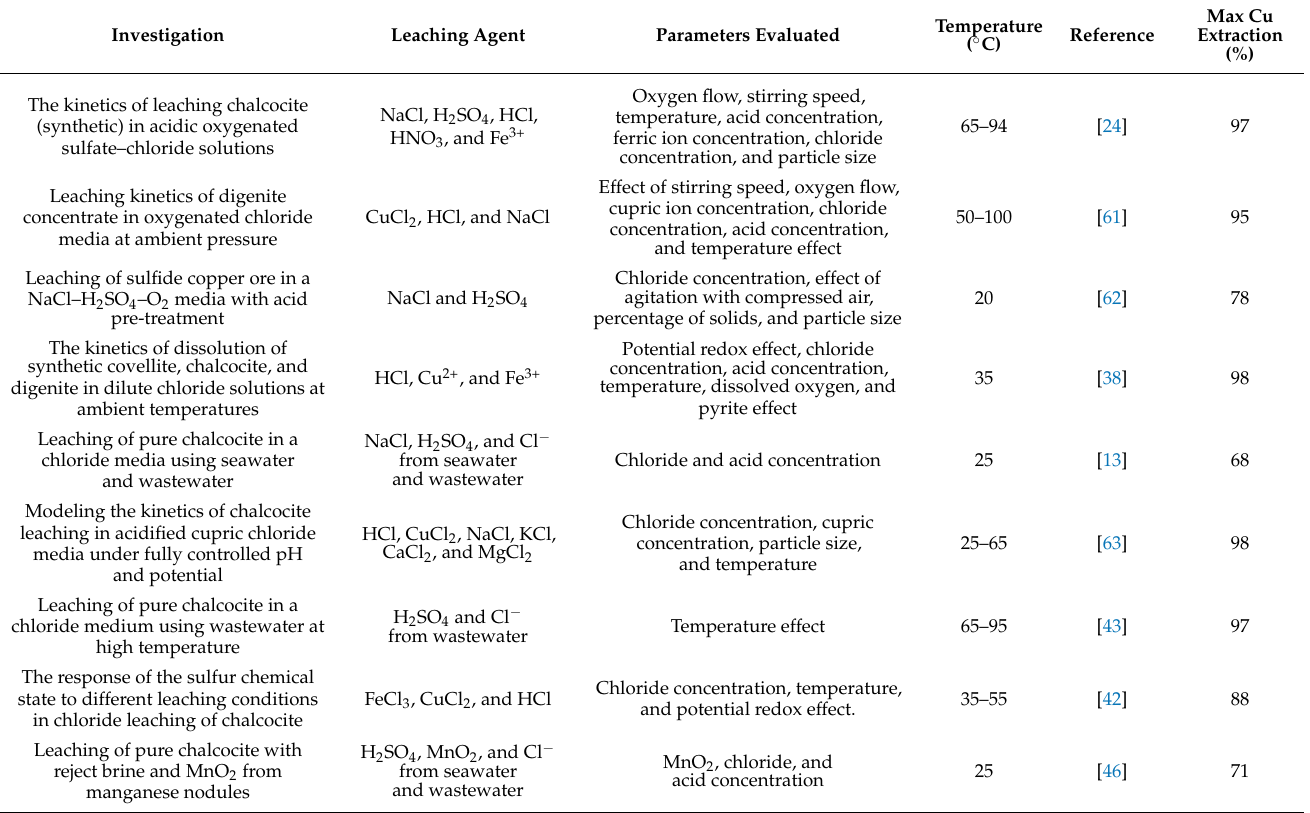
Table 2. Comparison of previous investigations for the leaching of chalcocite in a chloride